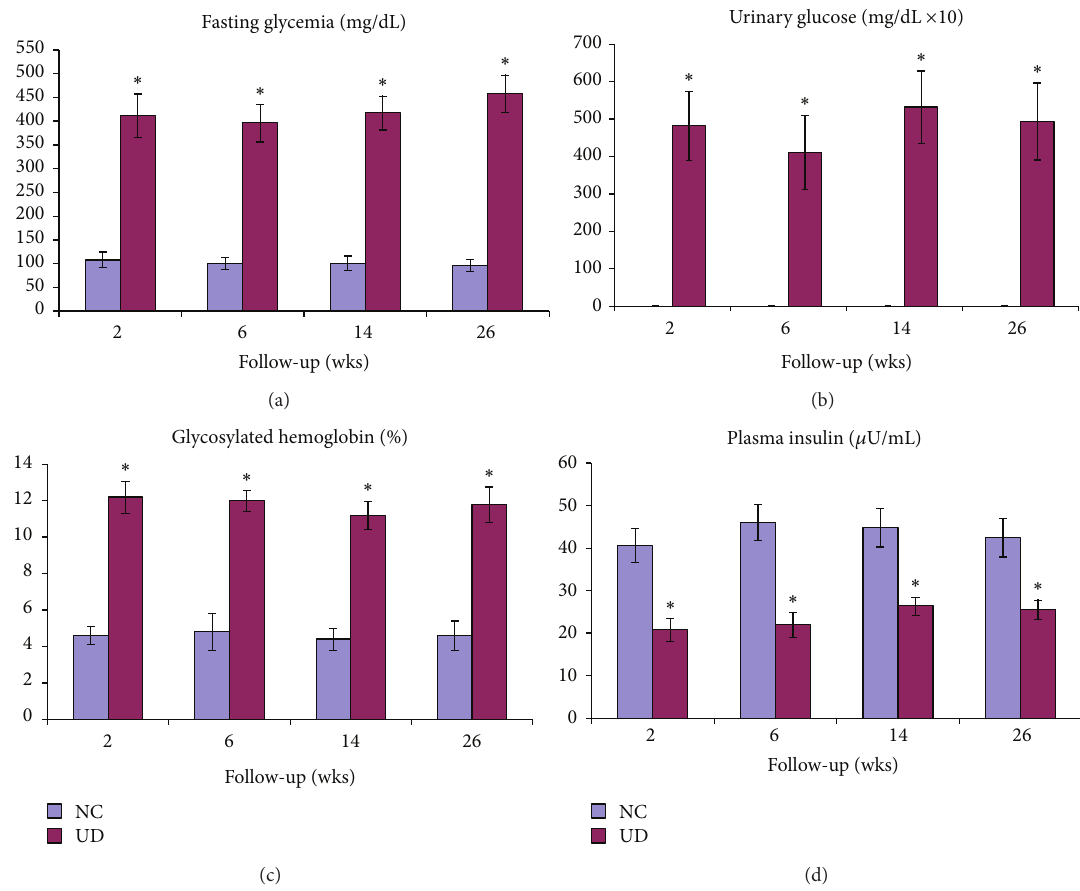
Figure 1: Mean ± SD of fasting glycemia (a), urinary glucose (b), glycosylated hemoglobin (c), and plasma insulin (d) in nondiabetic control (NC) and untreated diabetic animals (UD) during follow-up time, given in weeks.